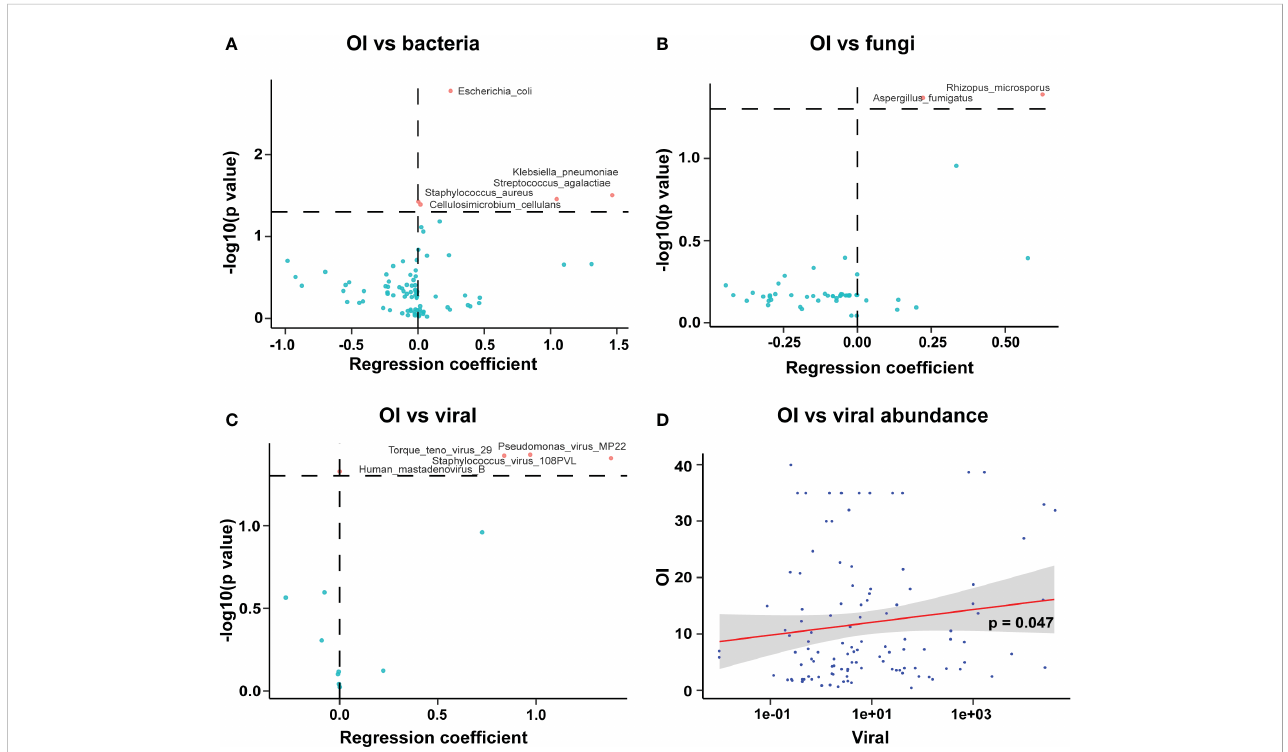
FIGURE 6 Correlation of oxygenation index with pathogenic microorganisms in BALF of patients with severe pneumonia. (A) The OI was positively correlated with the abundance of pathogenic bacteria in BALF; (B) The OI was positively correlated with the abundance of pathogenic fungi in BALF; (C) The OI was positively correlated with the abundance of viruses in BALF; (D) The OI was correlated with the overall abundance of viruses (viral abundance) in